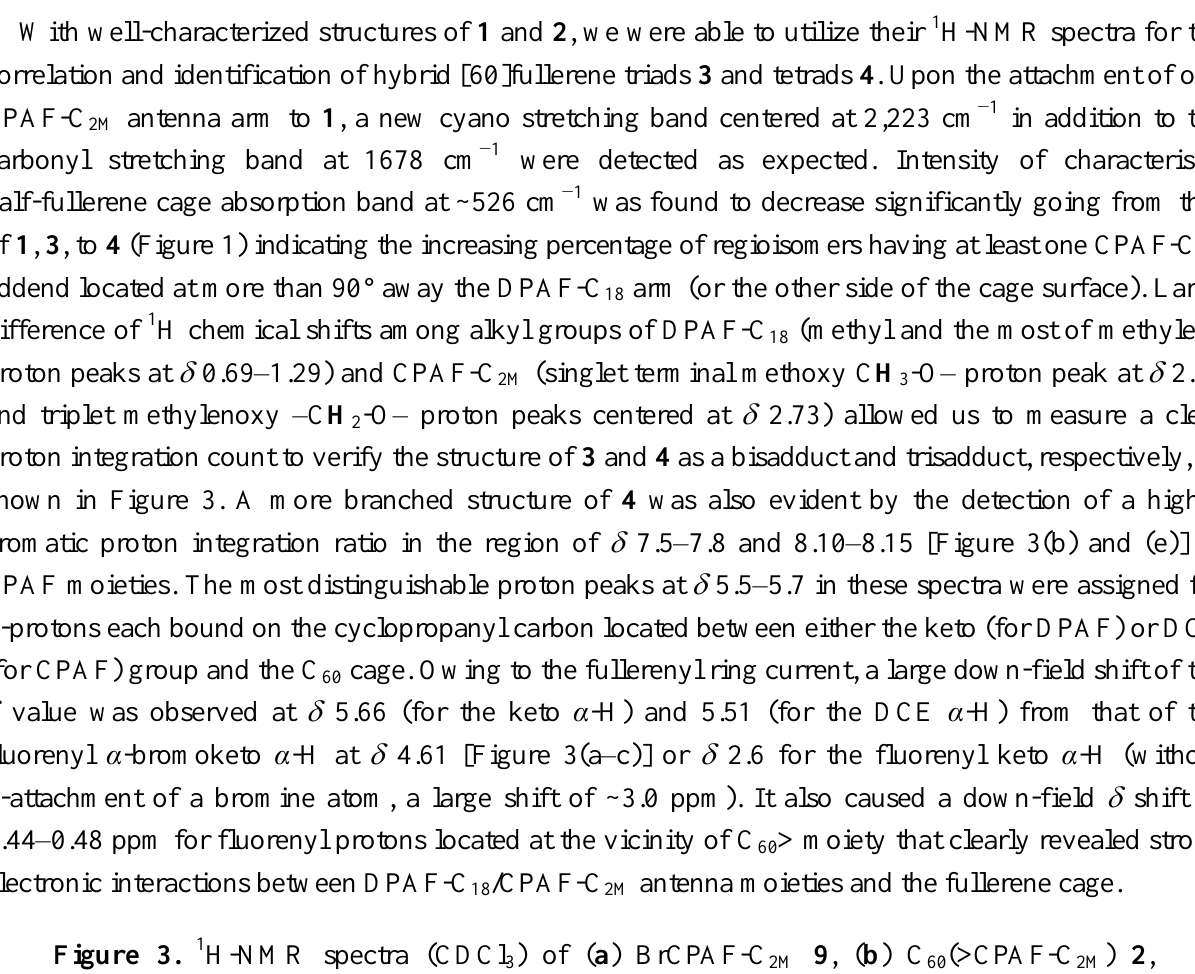
) of ( a ) BrCPAF-C 3 (>DPAF-C )(>CPAF-C 60 18